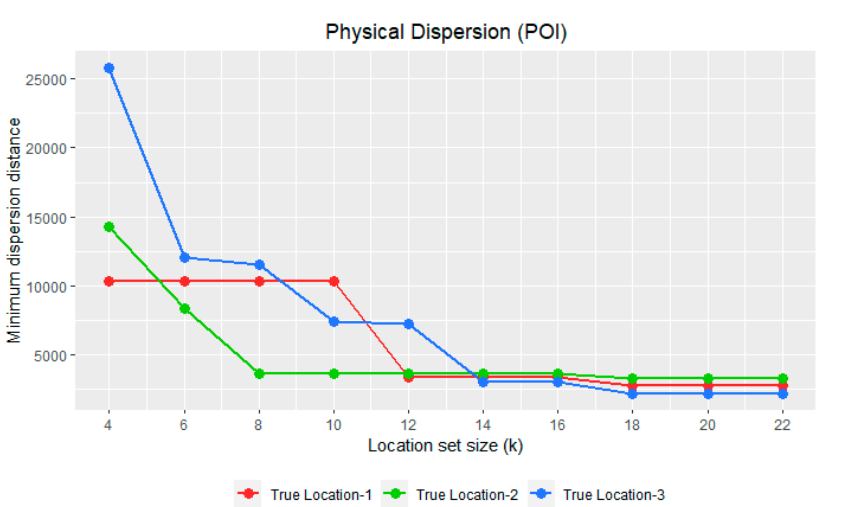
set ( k ) on X-axis and minimum dispersion distance (meters) on the Y-axis.